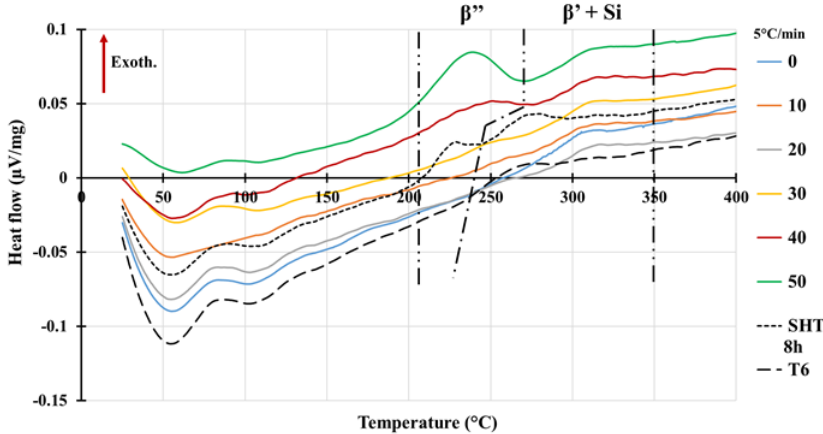
Figure 12. Differential thermal analysis (DTA) measurements at different building heights (Area 2) and representation of solution heat-treated (SHT) and T6 curves.